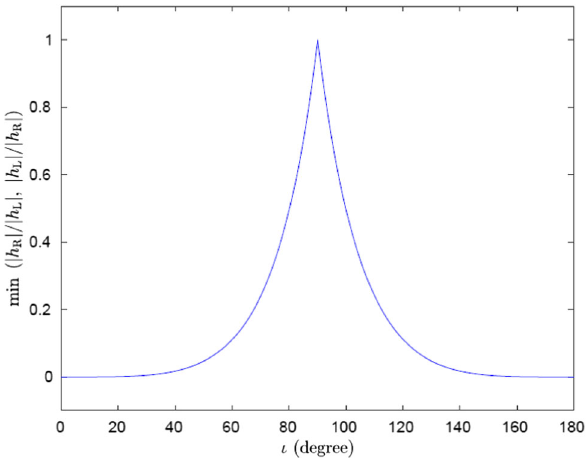
Fig. 1 The ratio between the amplitude of left-hand polarization and that of right-hand polarization as a function of the inclination angle ι